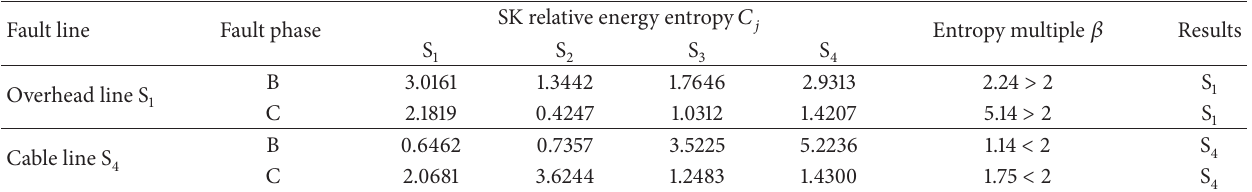
Table 8: SK relative energy entropy with different fault phases ( 𝜃 = 0 ∘ , 𝑅 = 20 Ω